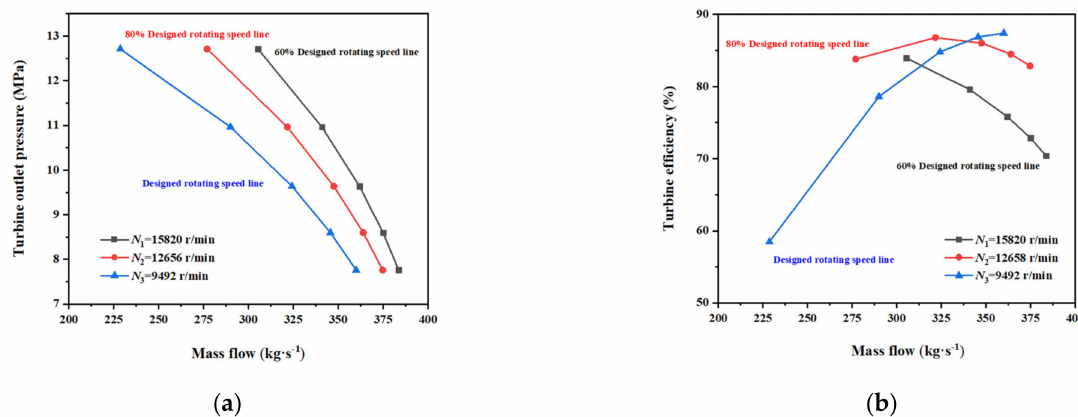
Figure 5. The performance prediction curves of the turbine. ( a ) Outlet pressure prediction of turbine. ( b ) Efficiency prediction of